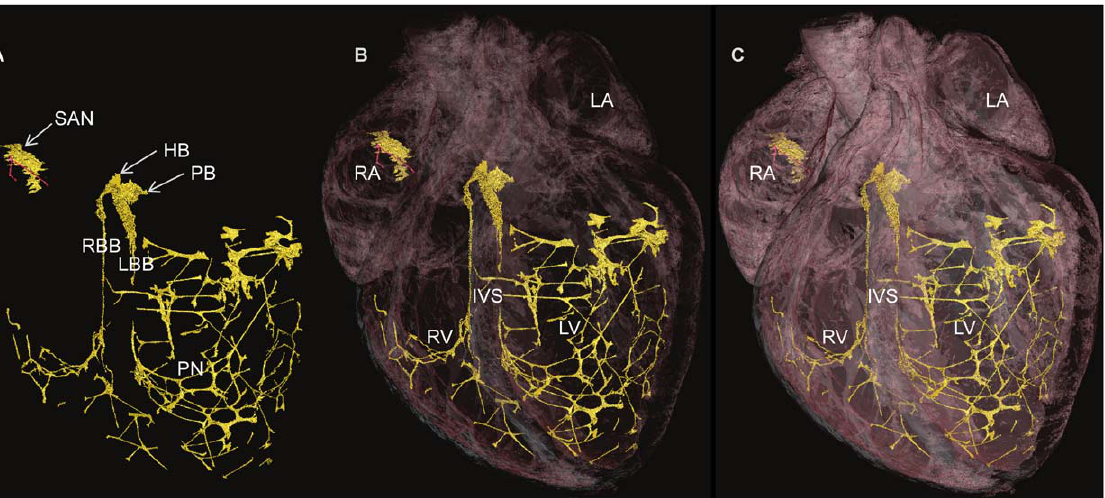
Figure 7. 3-D representation of the CCS in failed rabbit heart. Segmented 3D surface from showing the three major components of the CCS (yellow) (A). Overlaid with cardiac mass (pink) at decreasing levels of transparency (B,C) showing the penetrating bundle emerging from the right atrium and transversing the IVS as the His bundle (in true in situ position). HB- His bundle, LA- left atrium, LBB- left bundle branch, LV- left ventricle, PB- penetrating bundle, PN- Purkinje network, RA- right atrium, RBB- right bundle branch, RV- right ventricle, SAN- sinoatrial node, IVS-